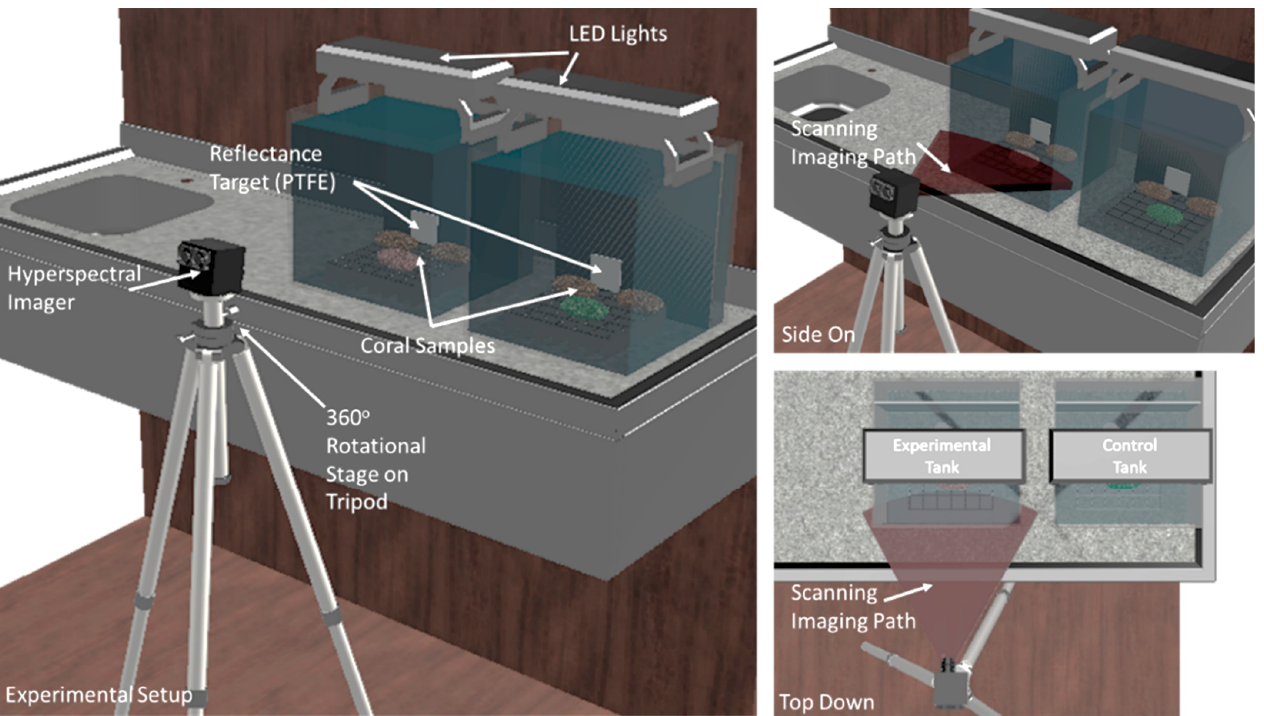
Figure 1. Experimental setup for hyperspectral imaging, where the imager is rotated on a 360° stage scanning the full width of the tank (as shown by scanning path). Imaging was conducted twice per tank; reflectance imaging under white light and fluorescence under royal blue (440 nm) light, this is then repeated for both the experimental and control tanks.